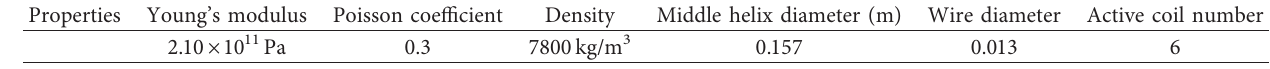
Table 3: Geometrical properties and material properties of the equal pitch spring.